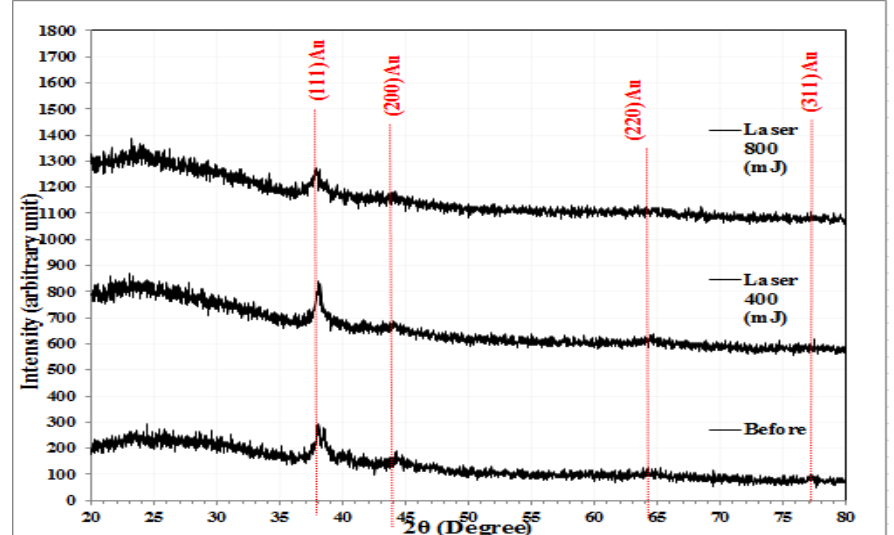
Fig. 8: X-ray diffraction pattern of B-alloy colloid NPs for exploding currents 75A and synthesized by (400m J, 800m J) laser energies